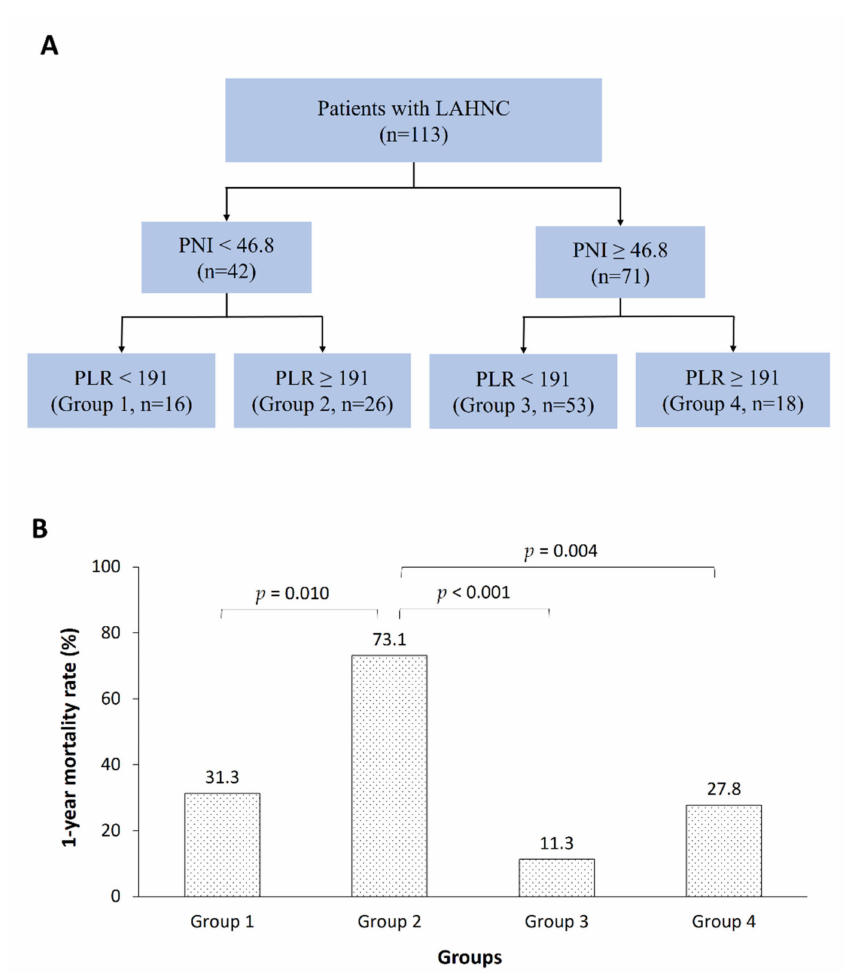
Figure 2. Risk groups based on the PNI and PLR combination predict the one year mortality rates of LAHNC patients undergoing CCRT. ( A ) Risk group stratification based on the PNI and PLR combination. ( B ) The one year mortality rates of the di ff erent risk groups by using the logistic regression model, adjusted for location, surgery, hemoglobin, TLC, albumin, BMI, NRI, and LBMI. LAHNC, locally advanced head and neck cancer; PNI, prognostic nutritional index; PLR, platelet-to-lymphocyte ratio; CCRT, concurrent